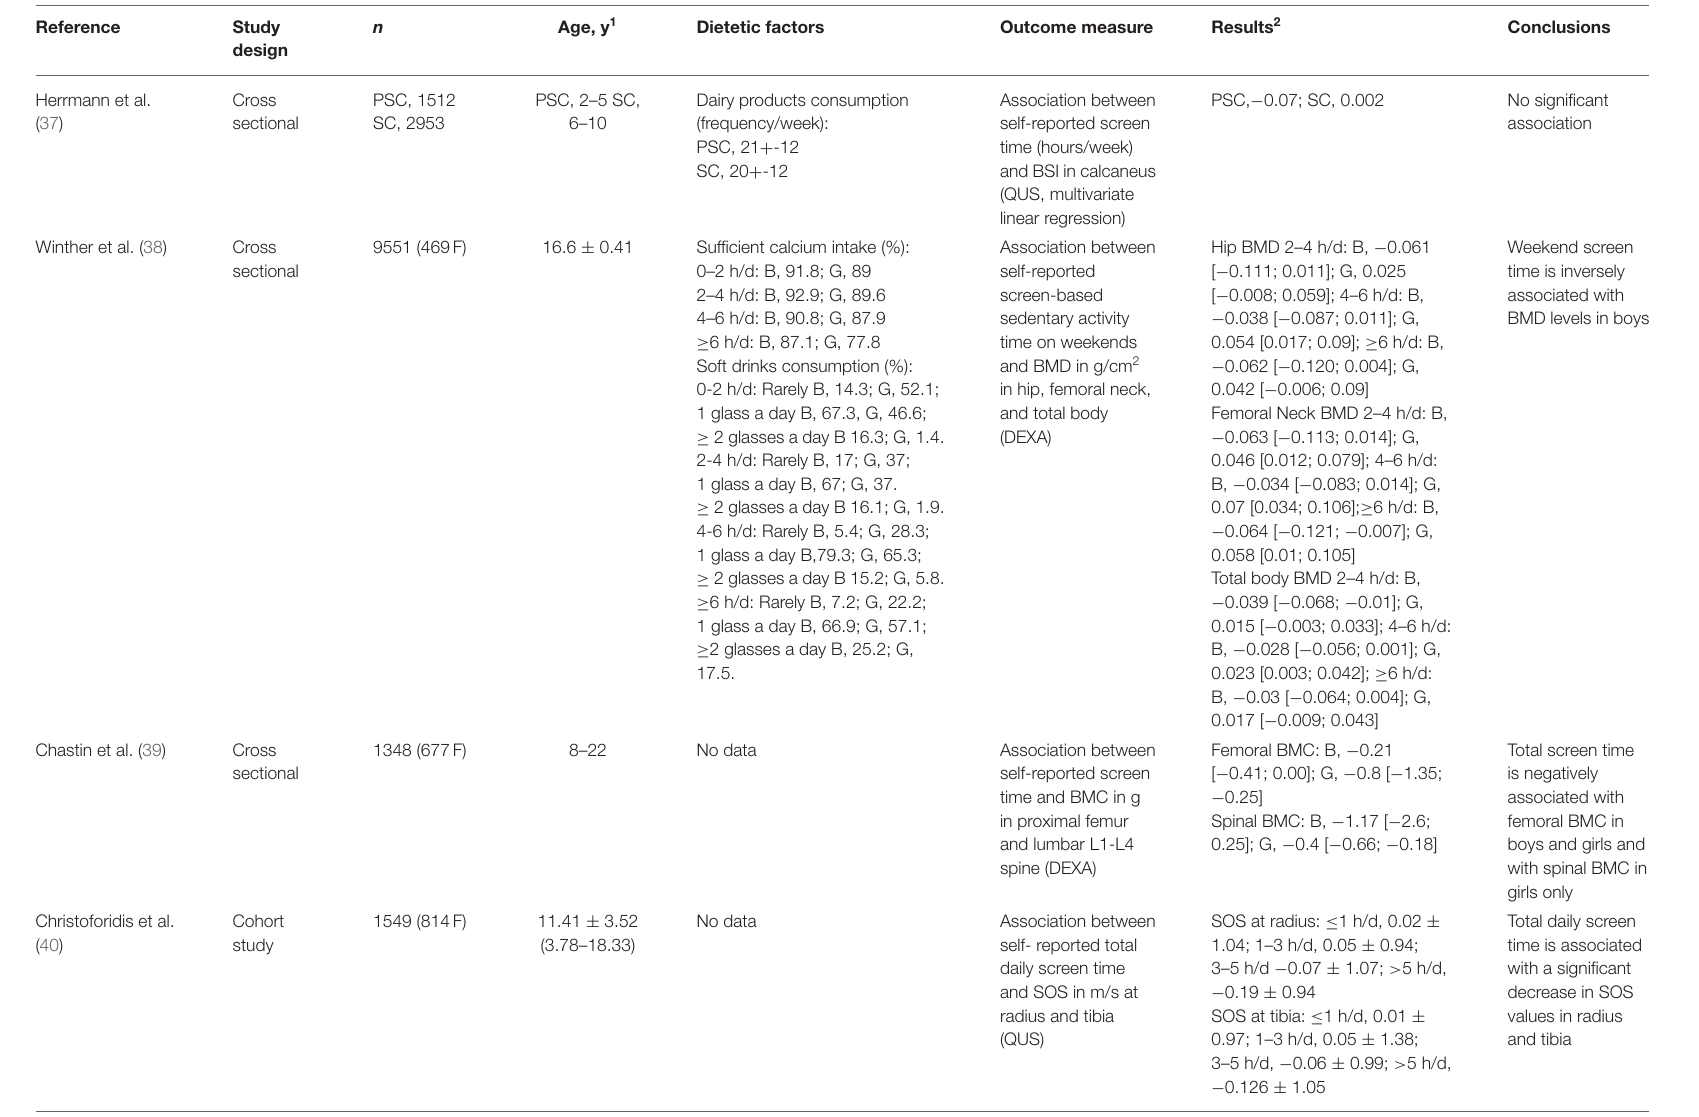
TABLE 1 | Effects of total screen time on bone